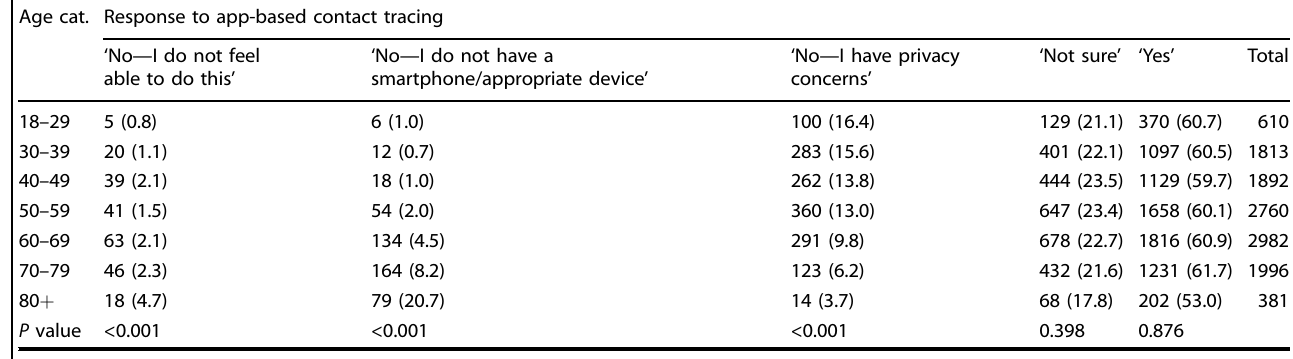
Table 2. Breakdown of responses to app-based contact tracing by age group. Age cat. Response to app-based contact